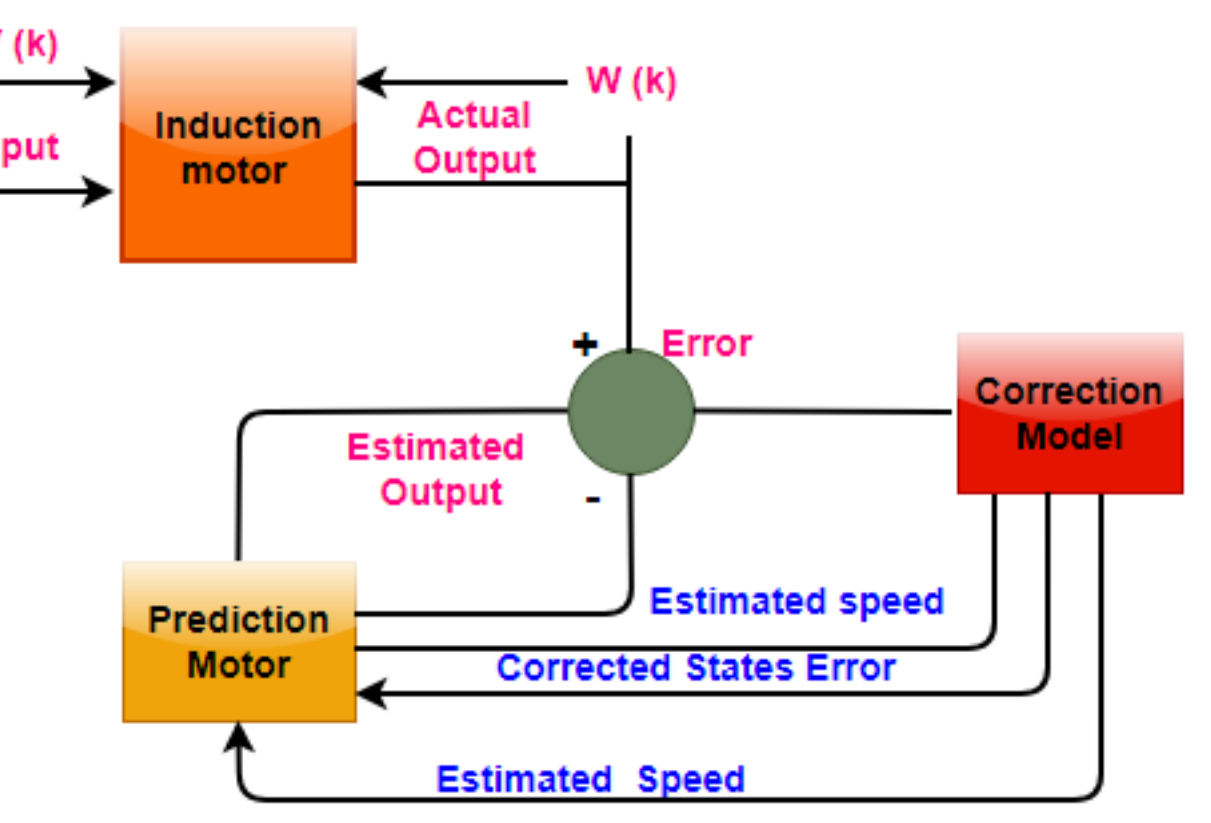
Figure 17. Extended Kalman filter.